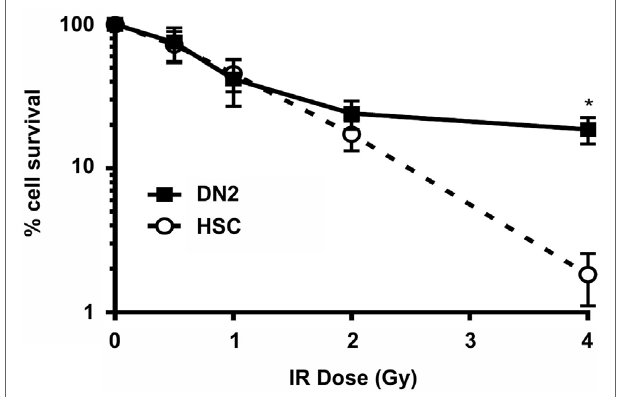
FigUre 1 | Double-negative (DN)2 thymocytes survive γ -irradiation in vitro . Clonogenic survival assays of mouse DN2 thymocytes and NH-hematopoietic stem cells (HSCs) γ -irradiated at 0.5–4 Gy and cultured for 3 or 5 days (depending on the cell type). Error bars represent mean ± SD, n = 3. * p < 0.05, two-way ANOVA analysis with Sidak’s multiple comparisons